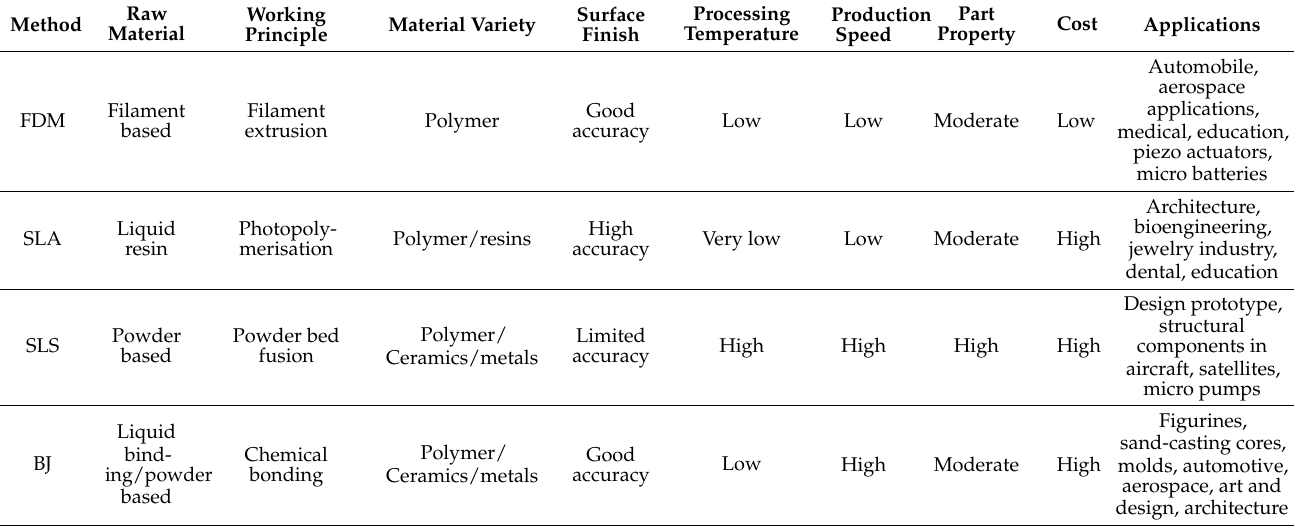
Table 1. Comparison between different AM processes discussed in the